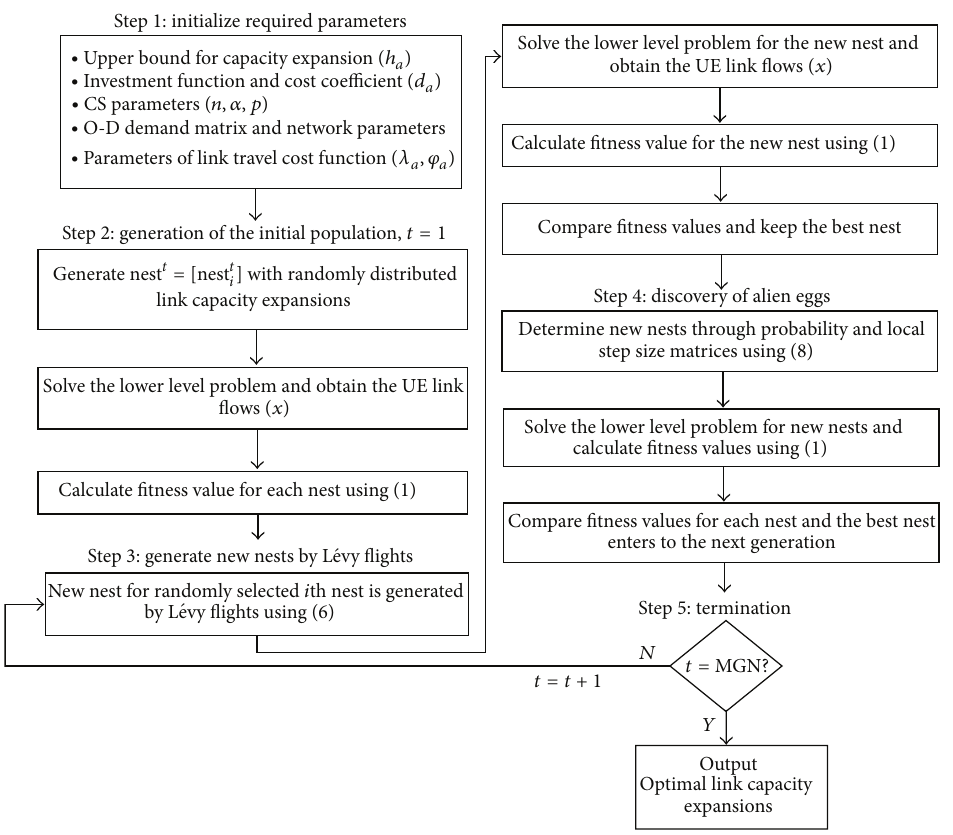
Figure 1: Flowchart of the CS for the